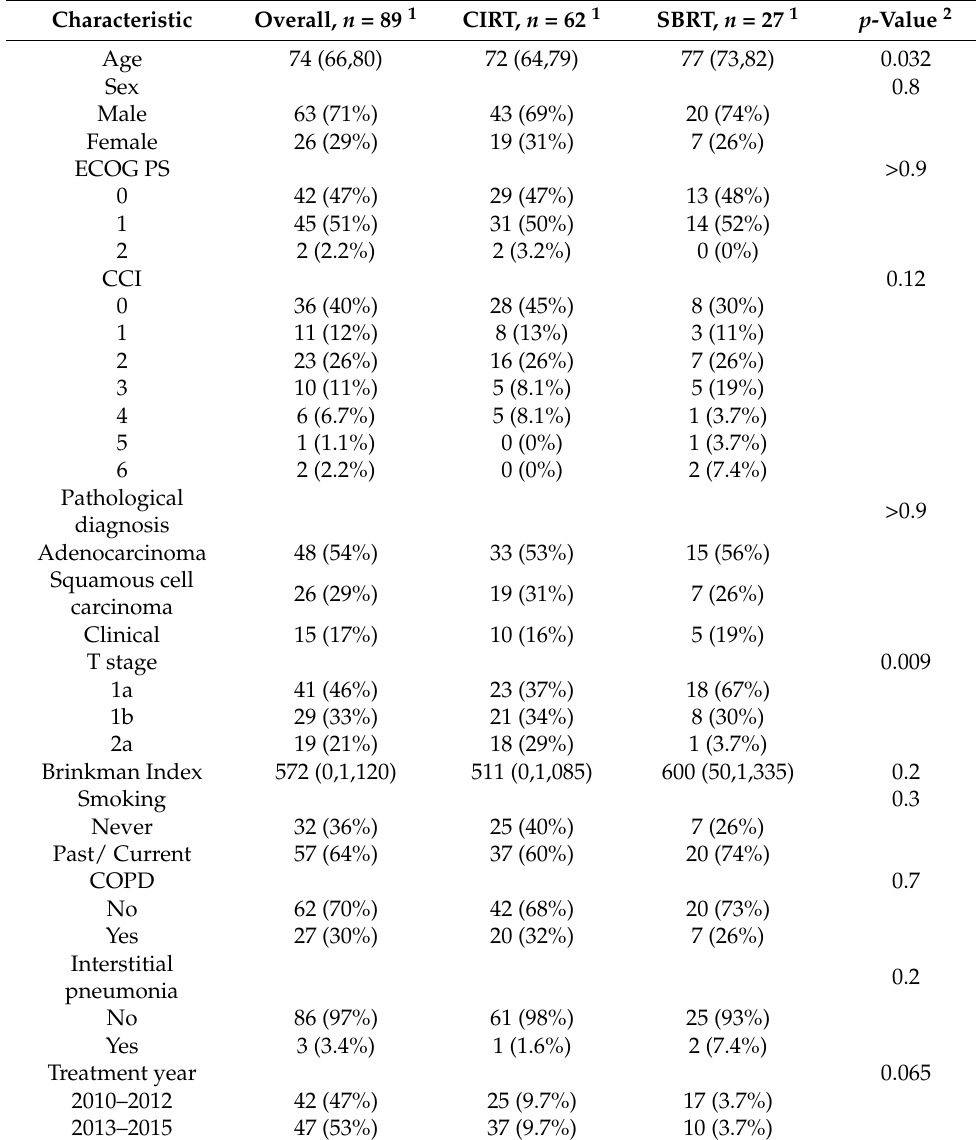
Table 1. Patient characteristics of the entire cohort ( n =